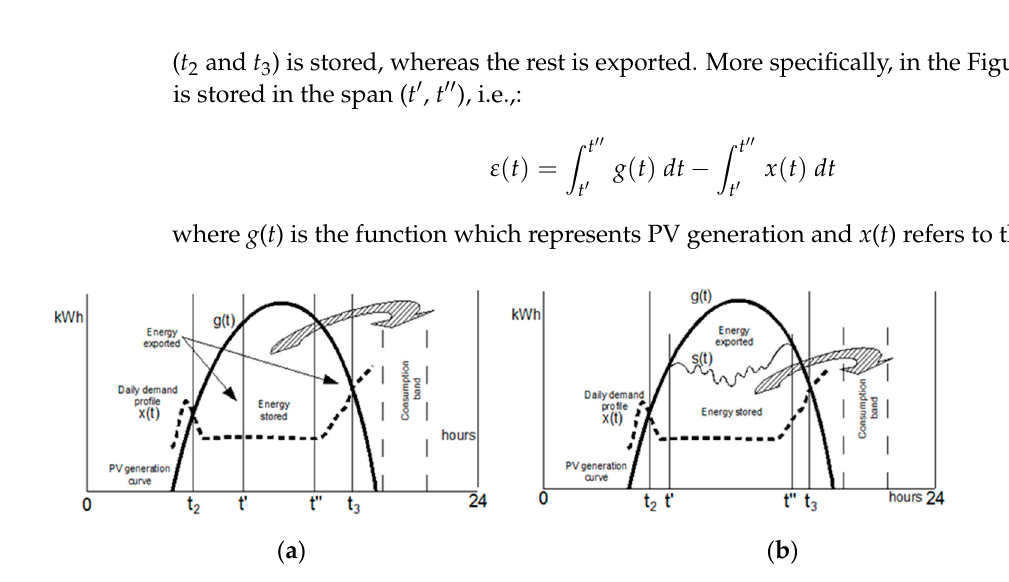
Figure 4. Trade-off between storage and exports: ( a ) energy is stored in a given time span; ( b ) storage takes place on a certain path. Source: own elaboration.